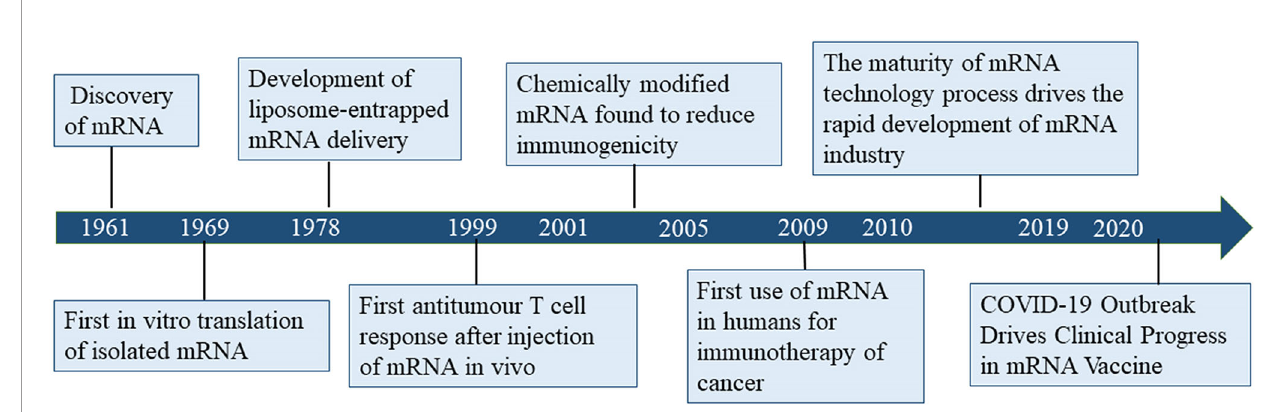
FIGURE 1 | Timeline of mRNA vaccine